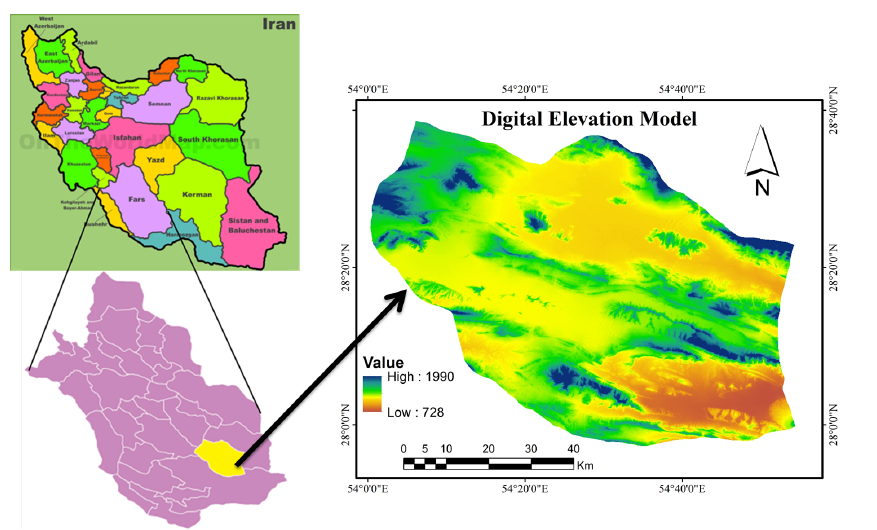
Figure 1: Position of Zarrin Dasht in Fars Province and